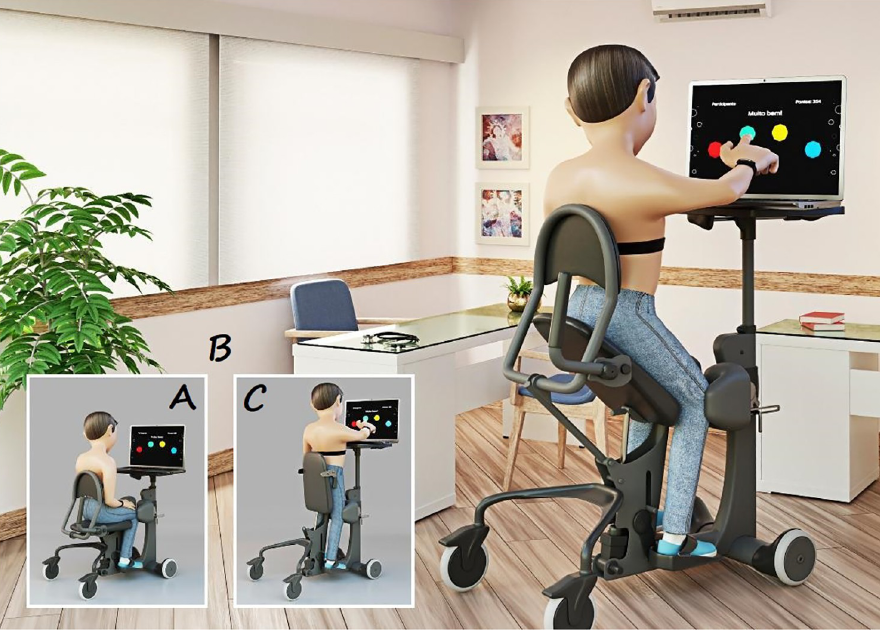
Fig 1. Illustrative drawing of the Easy Stand 1 . Representative design of the accomplishment of the Virtual Cognitive Task using the Touch Screen interface, wearing the Polar V800 chest strap heart rate receiver device. [A] sitting at rest at 0˚, [B] in elevation at 45˚ while performing the task, [C] orthostatism at 90˚ while performing the task. All degrees refer to the angle between the seat and the